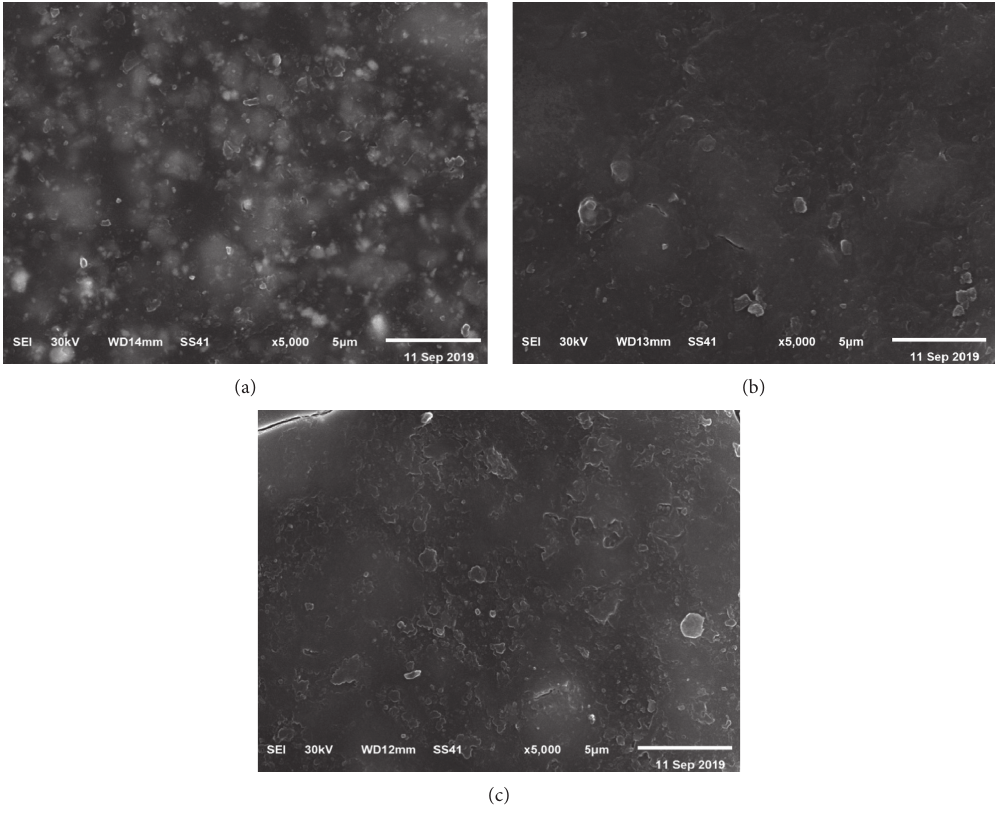
Figure 1: Scanning electron microscopy photographs of samples: (a) pure conventional Cention N (control), (b) Cention N at 5% (w/w) Al 2 O 3 NPa, and (c) Cention N at 10% (w/w) Al 2 O 3 NPa.